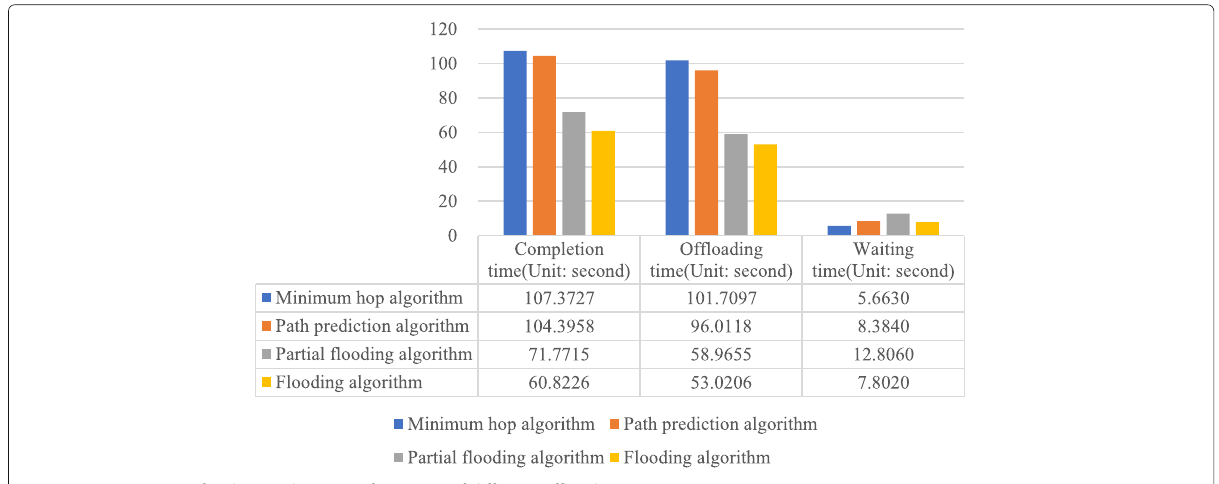
Fig. 10 Comparison of task completion performance of different offloading